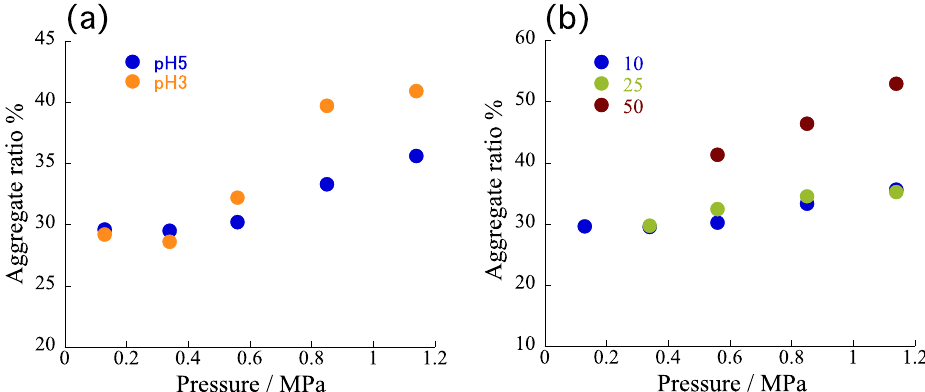
Figure 6. ( a ) Effects of proton concentration; comparative aggregation ratios at various values of pH, plotted with respect to pressure. ( b ) Pressure effects on the self-assembly efficiency at various proton diffusion times; plots of aggregation ratio with respect to pressure under various flow rates (pH 5).